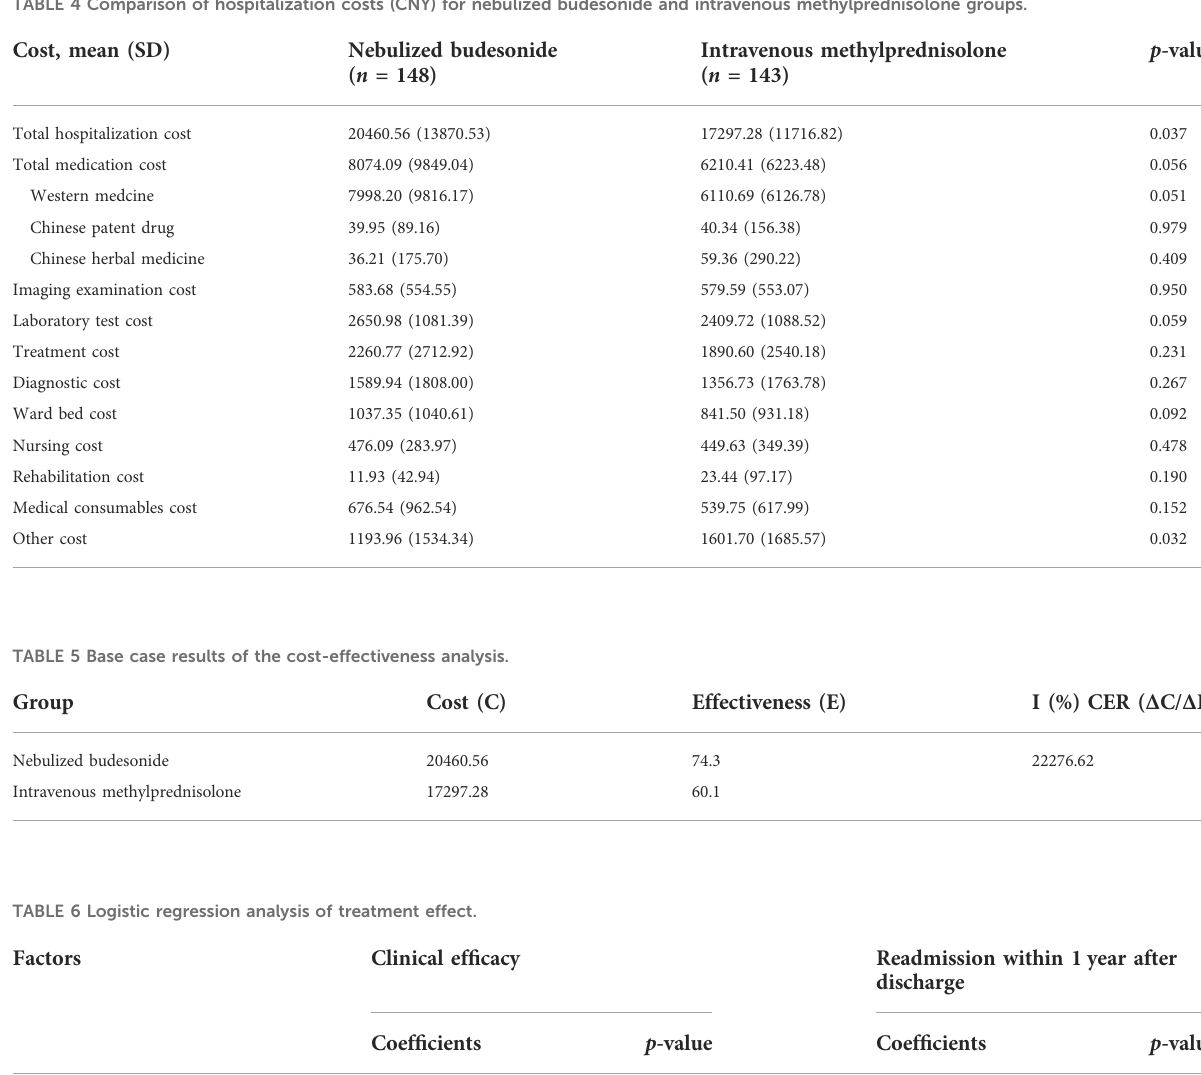
TABLE 4 Comparison of hospitalization costs (CNY) for nebulized budesonide and intravenous methylprednisolone groups.